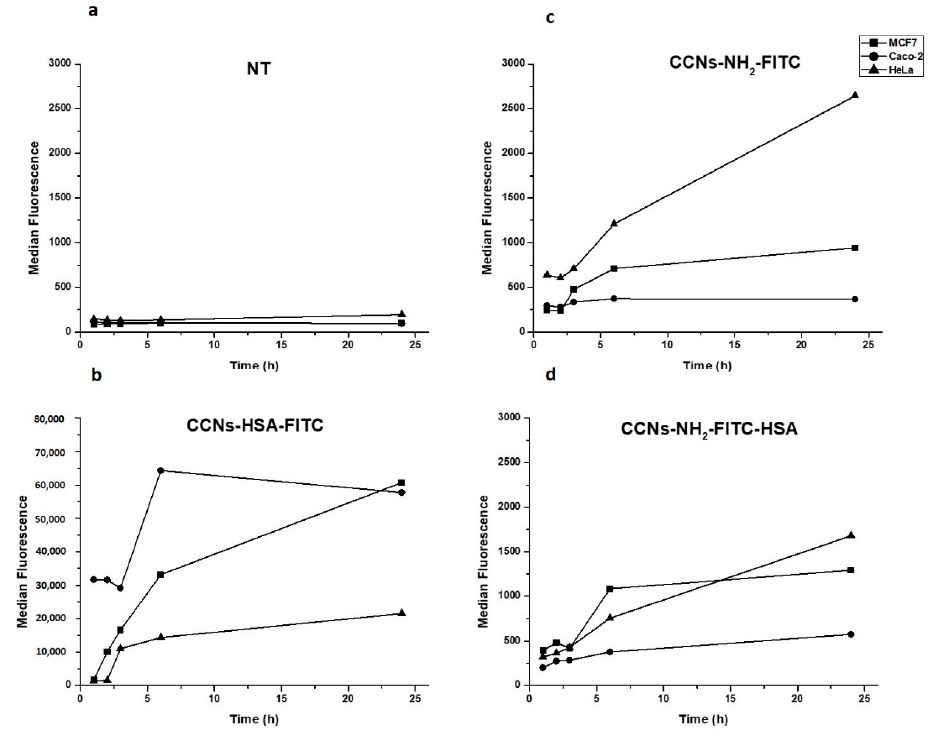
Figure 7. Uptake kinetics of non-treated sample NT ( a ), CCNs-NH 2 -FITC ( b ), CCNs-NH 2 -FITC-HSA ( c ) and CCNs-HSA-FITC (d) performed in MCF7 ( ■ ), Caco-2 ( ● ) and HeLa ( ▲ ) cells. Data were obtained from replicate experiments (n = 3).